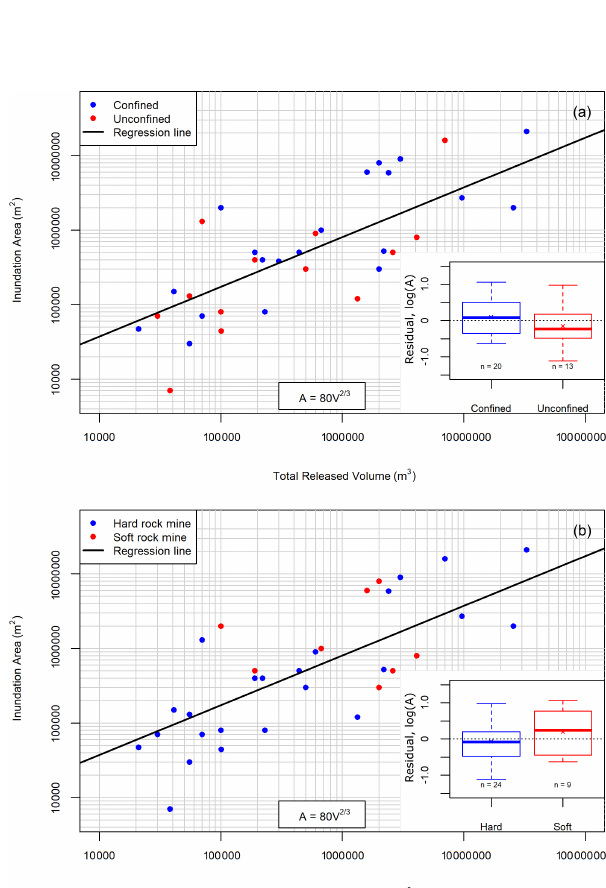
Figure 7. Colour-coded data points with respect to path confine- ment (a) and tailings type (b) . The solid black line is the specified two-thirds regression line. The insets show the box plots of the area– volume residuals for the bivariate regression line with a specified two-thirds